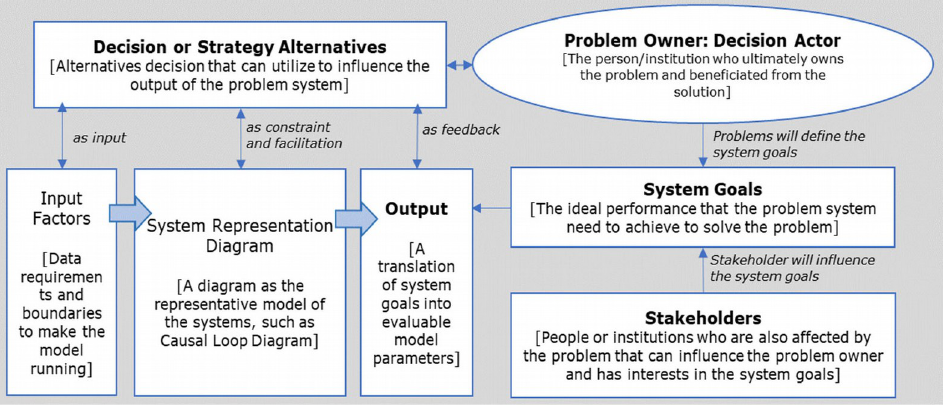
Figure 4. System diagram in input-process-output